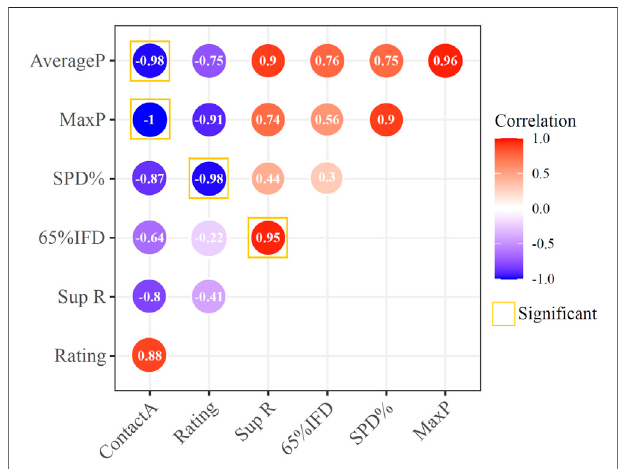
FIGURE 8 | Correlation analysis between subjective rating and pressure